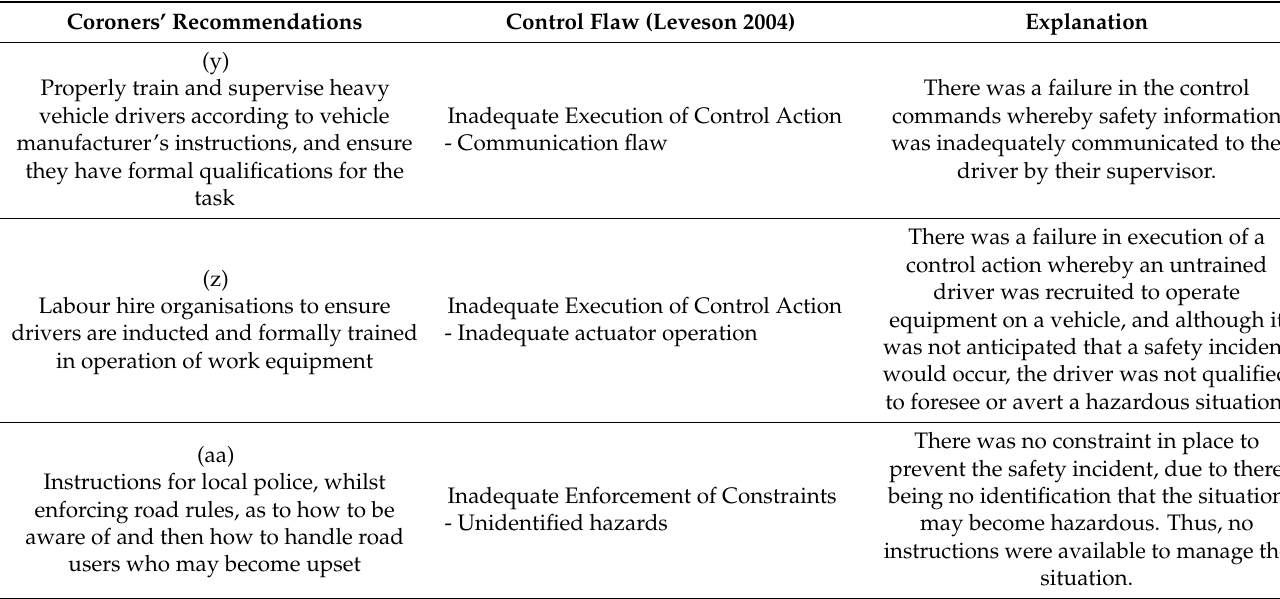
Table 9. Coroners’ Recommendations Mapped at STAMP Level 4—Local Management and Assigned to a Control Flaw ( n =